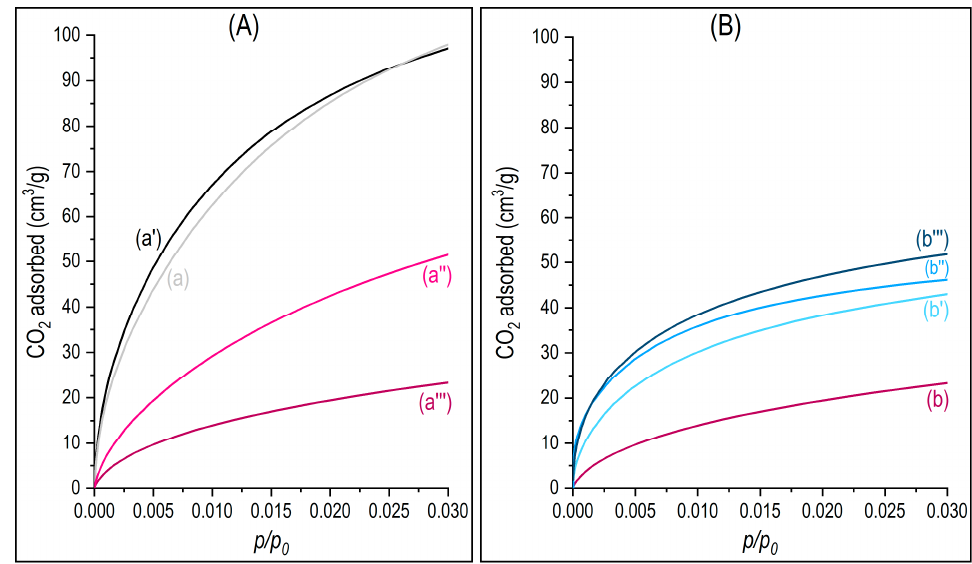
Figure 4. CO 2 isotherms collected at 0 °C for: ( A ) Ni loading and Si/Al samples: ( a ) 5Ni/USY(3), ( a ′ ) 15Ni/USY(3), ( a ″ ) 15Ni/USY(15), and ( a ‴ ) 15Ni/USY(38); and ( B ) Framework type samples: ( b ) 15Ni/USY(38), ( b’ ) 15Ni/BEA(38), ( b ″ ) 15Ni/ZSM5(40), and ( b ‴ ) 15Ni/MOR(47). Note that the y-axis is different in both graphs, to clearly see differences between the isotherms obtained for samples presented in ( B ).